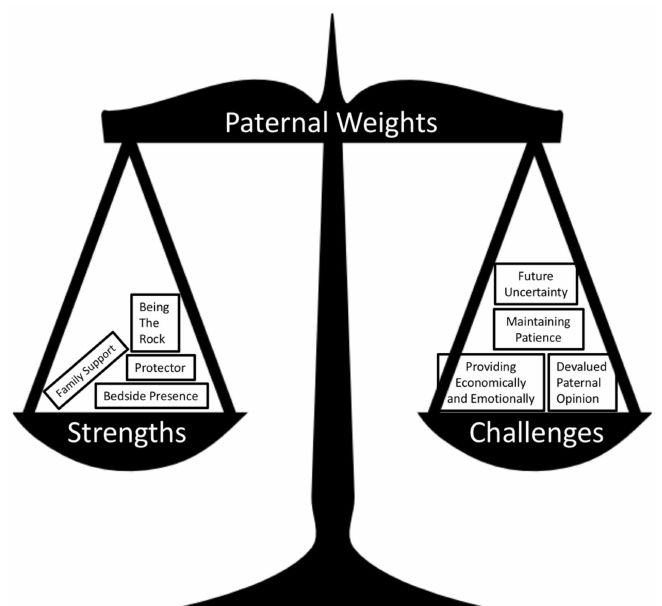
Figure 2. Symbolic representation of the conflicting weights experienced by fathers in their care for their child. Each box is a specific theme extracted from paternal